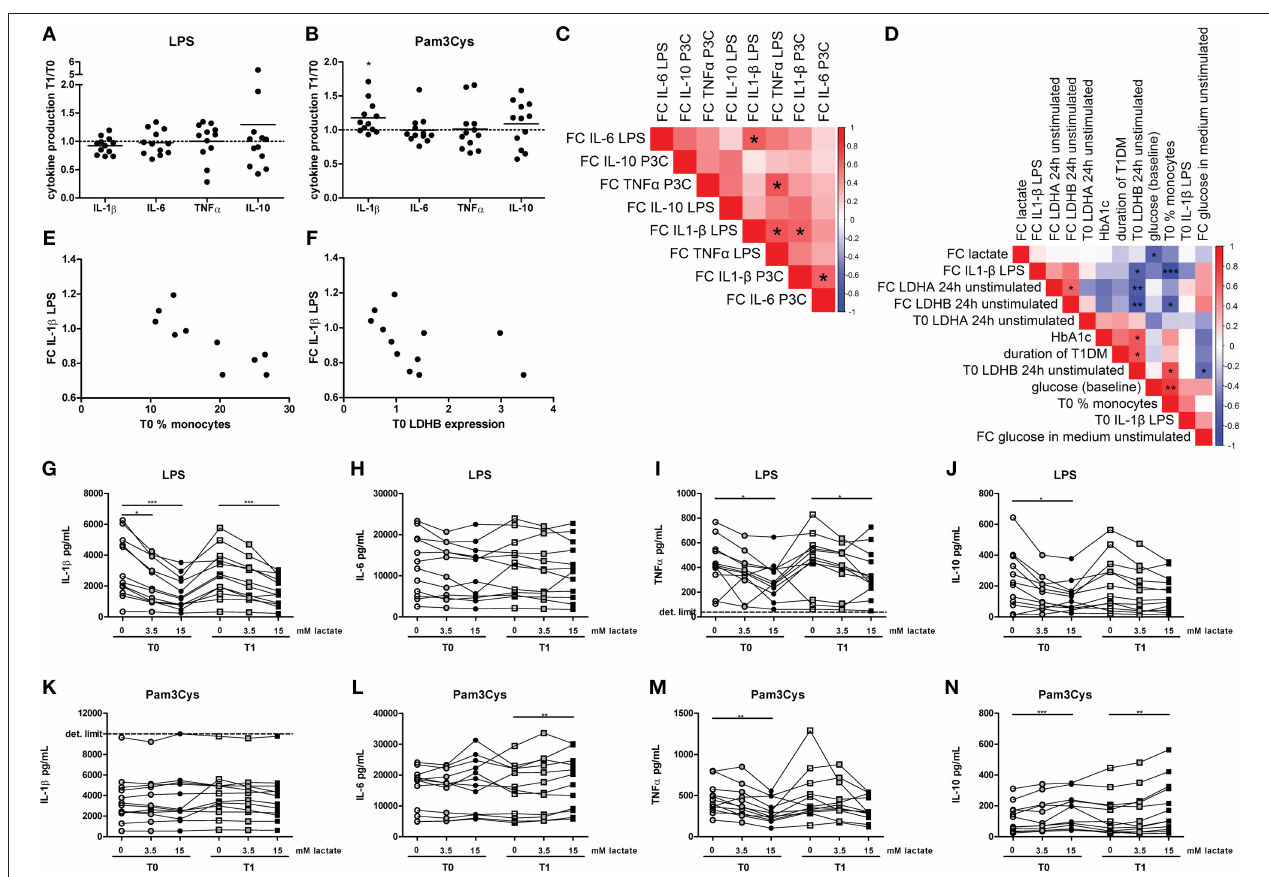
FIGURE 6 | A short-term lactate infusion only has minor effects on cytokine production of human PBMCs. PBMCs were isolated and stimulated either before (T0) or after (T1) lactate infusion. (A,B) Change in LPS- (A) and Pam3Cys- (B) induced cytokine production after lactate infusion. (C) Correlation heatmap indicating correlations between changes in cytokine production after lactate infusion. Colors indicate Spearman correlation coefficients. FC, Fold change T1/T0. (D) Correlation heatmap indicating correlations between changes in LPS-induced IL-1 β production after lactate infusion and various clinical and experimental factors. (E,F) Correlation of changes in LPS-induced IL-1 β production after lactate infusion with percentage of monocytes in the PBMC fraction (E) and gene expression levels of LDHB (F) . (G–N) Cytokine production of human PBMCs pretreated with lactate for 1h before LPS (G–J) or Pam3Cys (K–N) was added for 24h. n = 12. * p < 0.05, ** p < 0.01, *** p < 0.001. Wilcoxon signed rank test (A,B) Spearman’s rank test (C–F) Friedman test with post-hoc Dunn’s test (G–N)